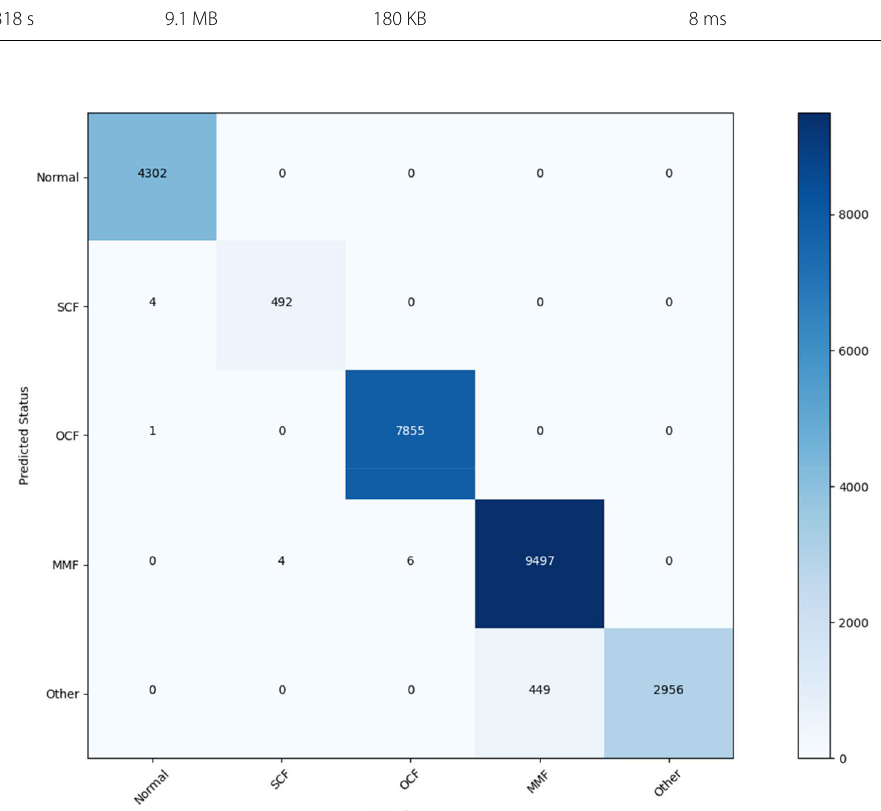
Fig. 6 5 5 confusion ×